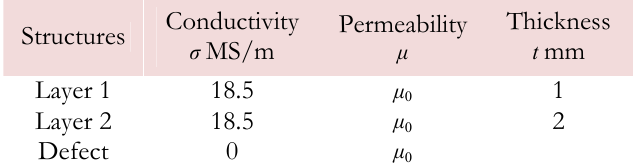
Table 2: Structure parameters.